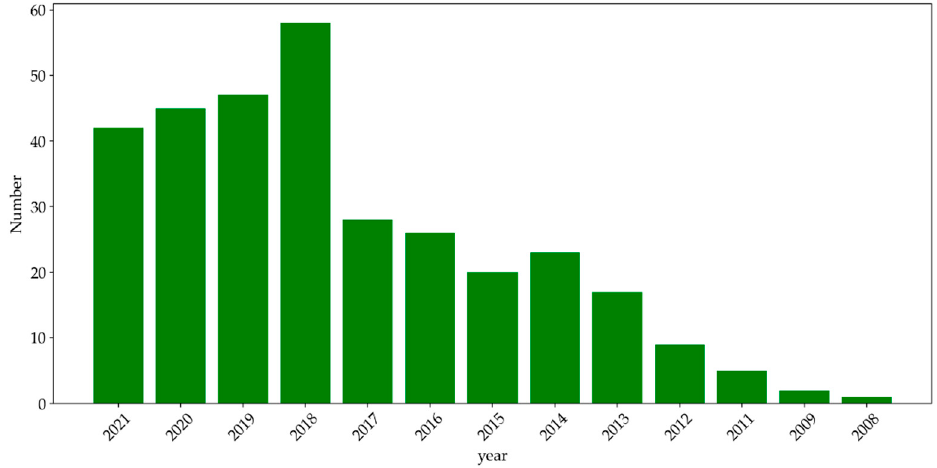
Figure 3. Published number of literature related to the service and operation of BSS.